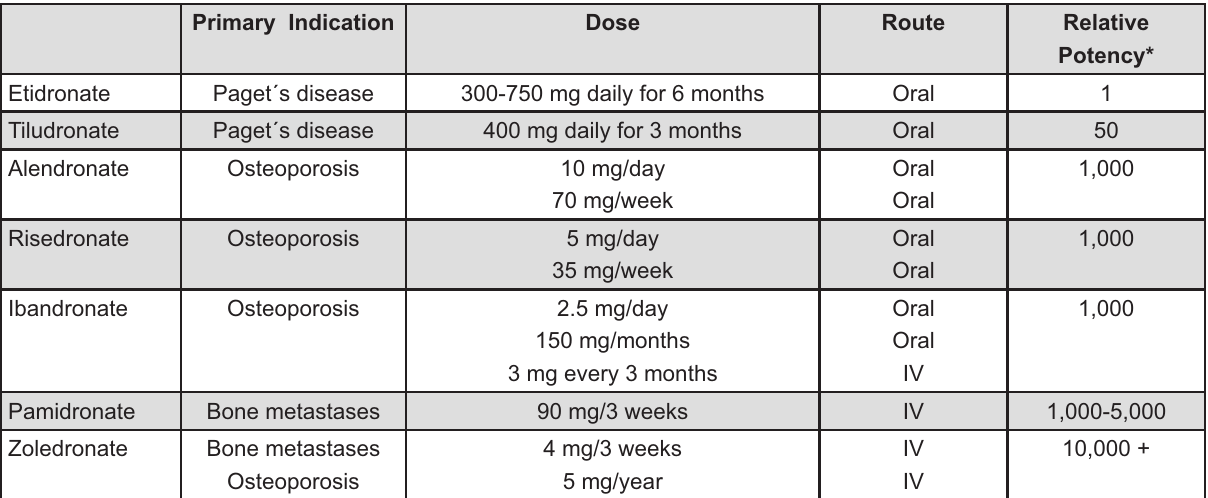
Figure 1- Bisphosphonate preparations currently available in the United States (Abbreviation: Intravenous - IV, *Relative to etidronate) various tissue-level properties 5,7,27,42